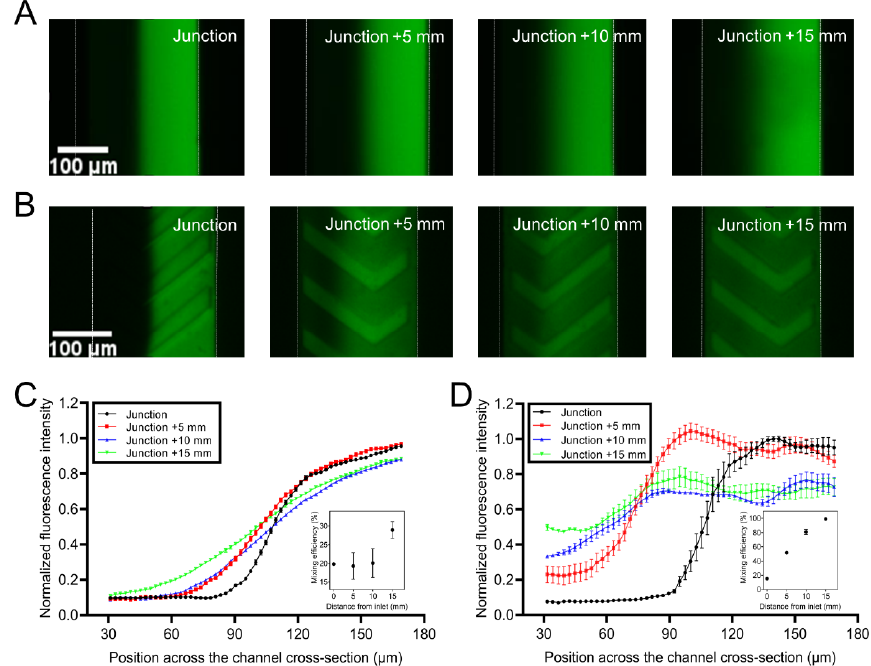
Figure 6. The mixing efficiency study. The images of the channels at different locations after dye and water were injected into devices ( A ) without and ( B ) with herringbone microstructures. The normalized fluorescence intensity based on the highest value of the fluorescent across the channels for the mixing characterization after flowing various distances in devices ( C ) without and ( D ) with herringbone microstructures. (Insets) Mixing efficiency after flowing varied distances in devices (C) without and ( D ) with herringbone microstructures. Error bars represent the standard error of the mean of five replicates.